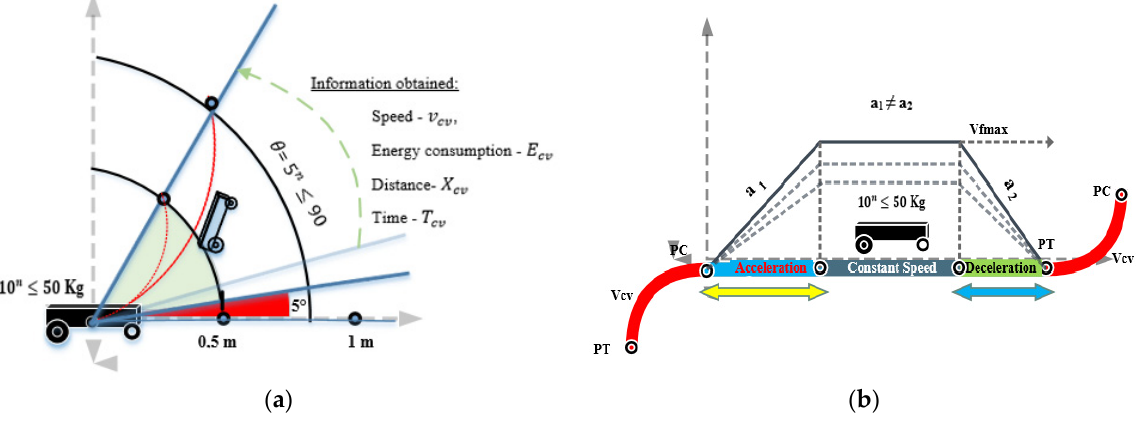
Figure 7. ( a ) Speed profiling, ( b ) acceleration